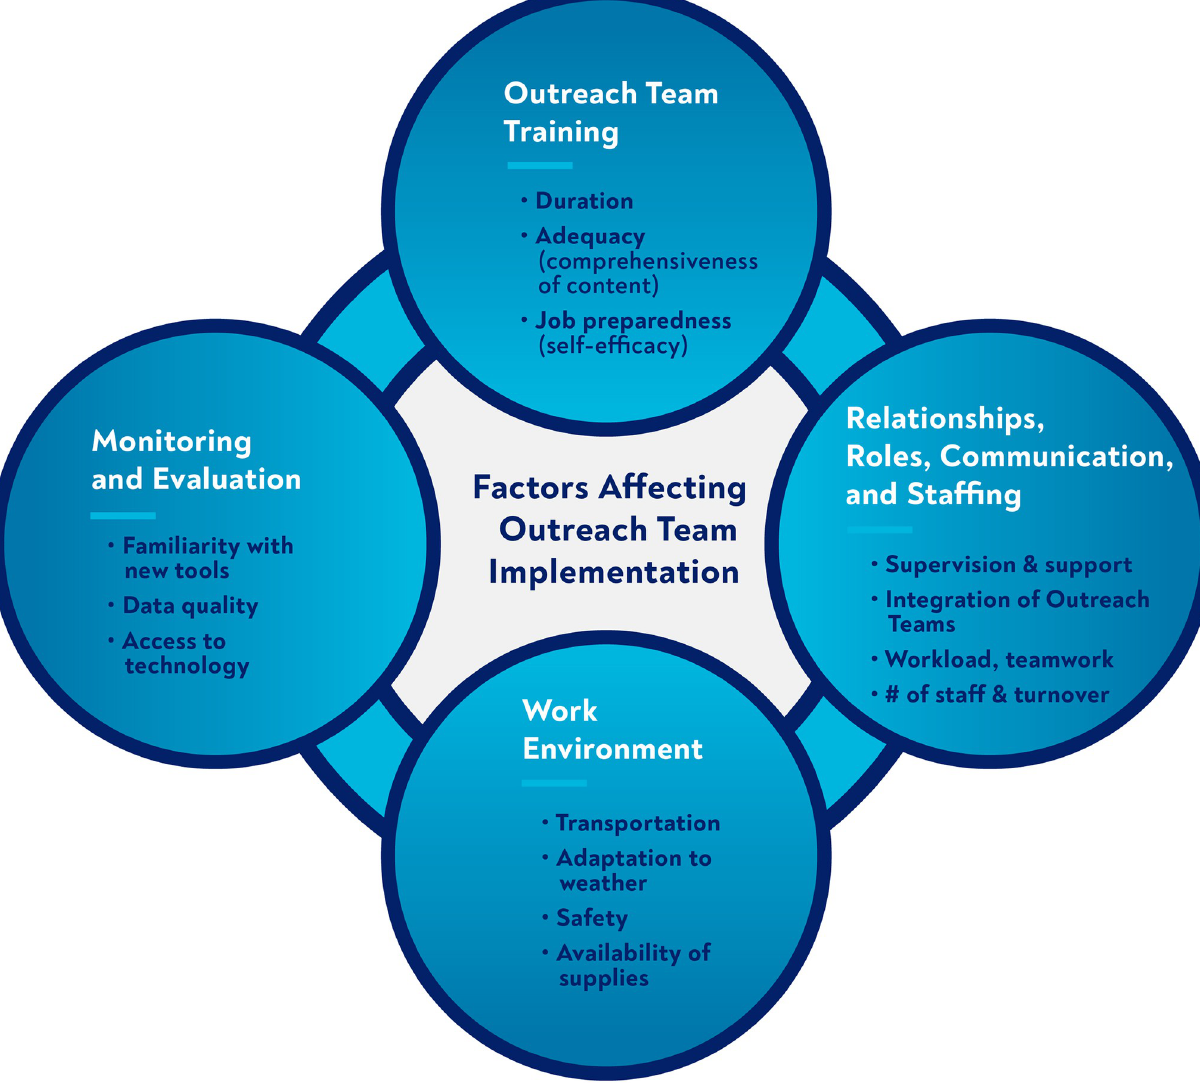
Fig 3. Key factors affecting implementation of expanded outreach team